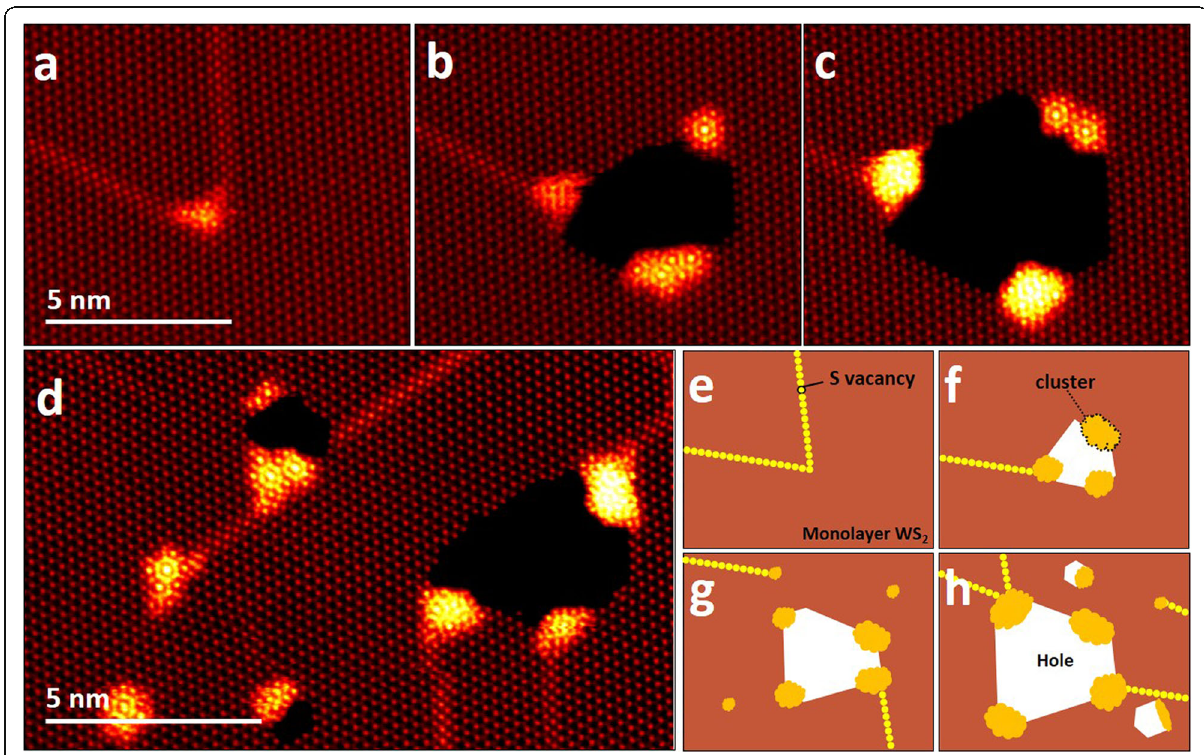
Fig. 1 a – c ADF-STEM images showing the formation of atomic clusters at edges of a hole in the monolayer WS 2 . d ADF-STEM image showing extended holes with line defects and clusters. e – h Simple successive schematics showing a whole process for the formation of clusters and holes from line defects in the monolayer WS 2